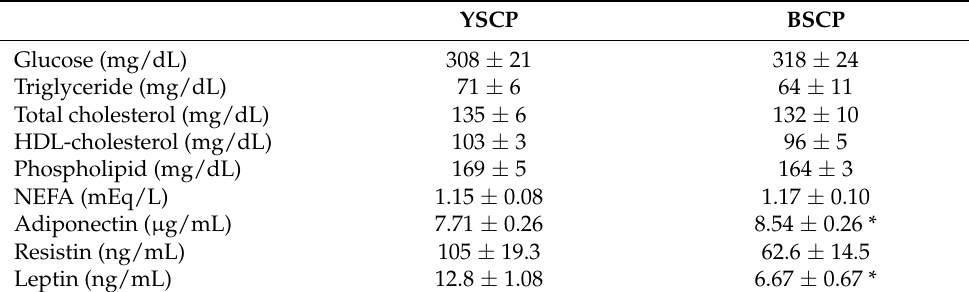
Table 4. Blood serum parameters and adipocytokines levels in mice.